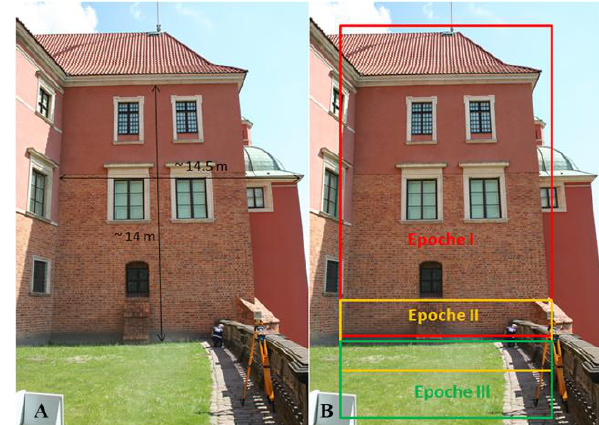
Figure 1. The tower with marked